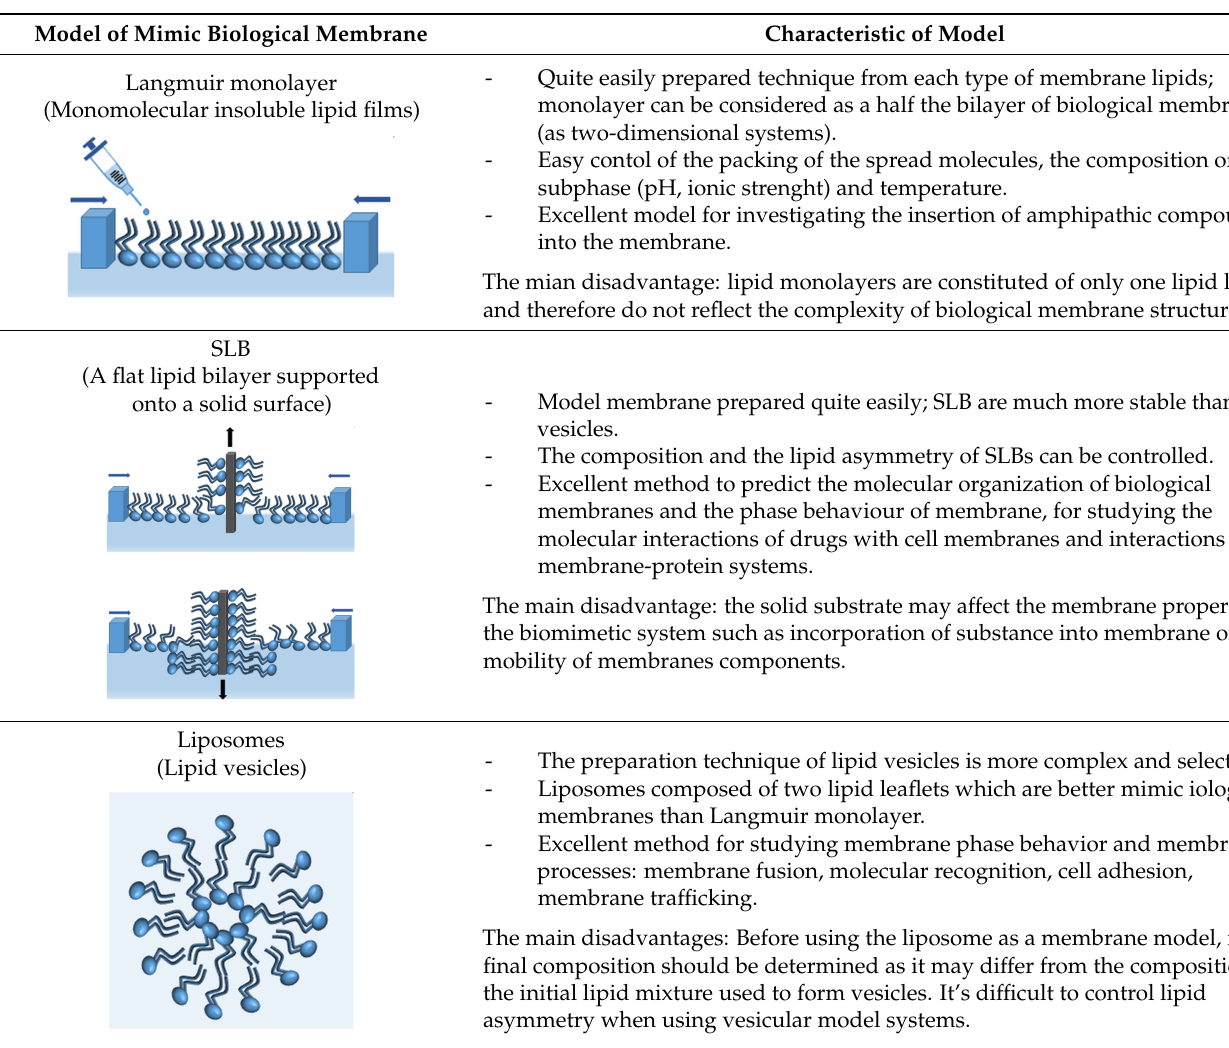
Table 2. Characteristic of biomimetic model